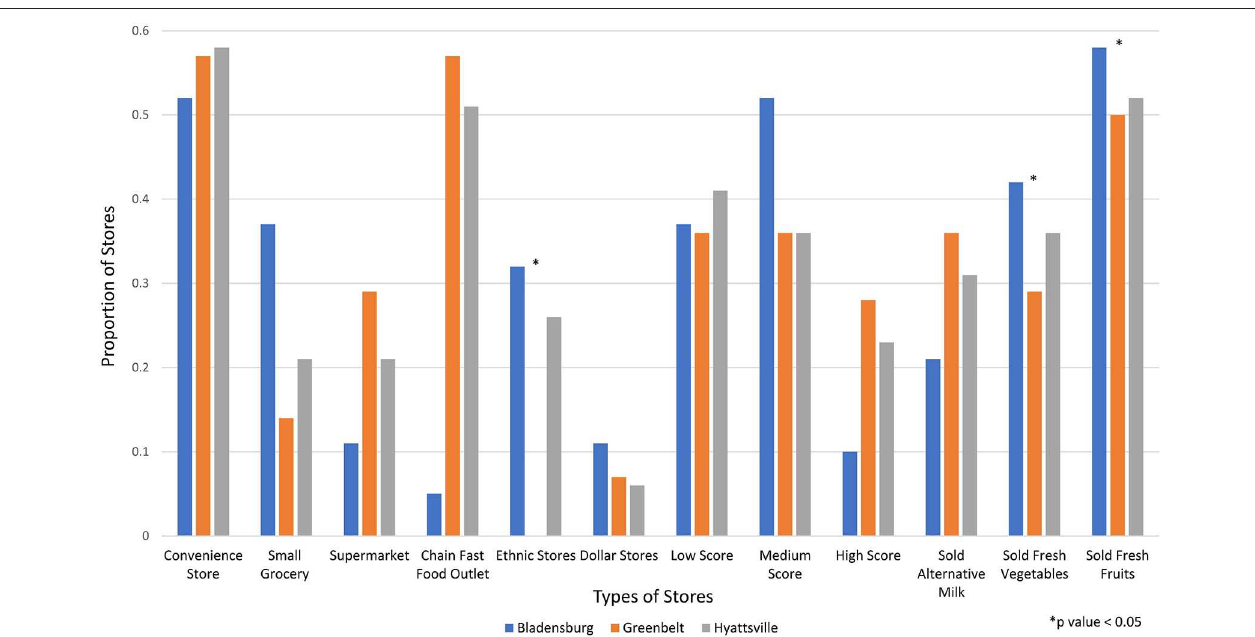
FIGURE 1 | Proportions of different store categories and features across Bladensburg, Greenbelt, and Hyattsville, MD (2018).